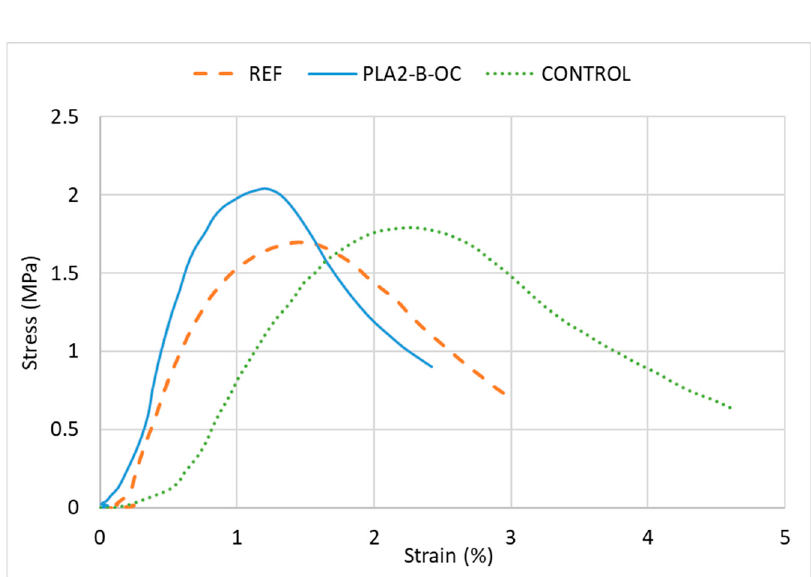
Table 9. p -values for cracking energy results.